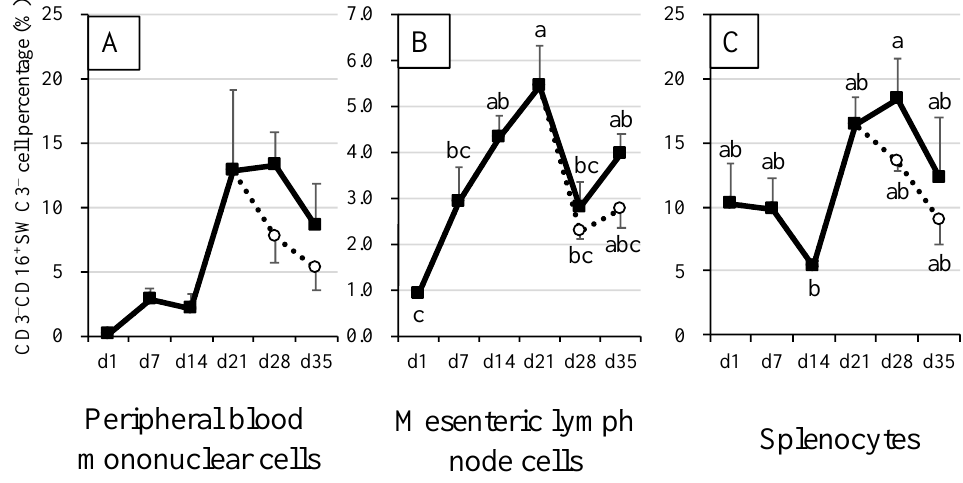
Figure 2. Natural killer cell population in peripheral blood mononuclear cells, mesenteric lymph node (MLN) cells and splenocytes of piglets. CD3 – CD16 + SWC3 – cells were considered as natural killer (NK) cells. Closed squares indicate the mean values for suckling piglets. Open circles indicate the mean values for piglets weaned at 21 days of age. The error bars represent the standard errors. Different superscripts indicate significant differences between groups. Panel ( A ), NK cell population in peripheral blood mononuclear cell. Panel ( B ), NK cell population in MLN cells. Panel ( C ), NK cell population in splenocytes.